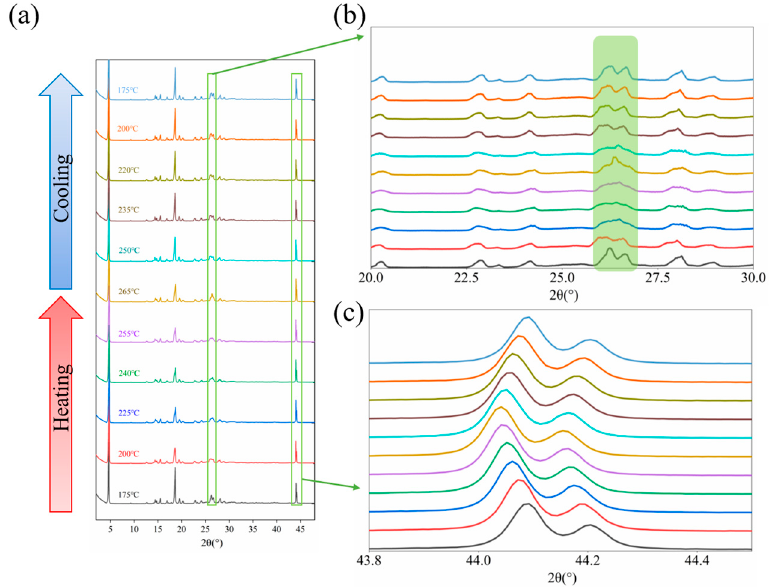
Figure 4. ( a ) VT-PXRD patterns of TMP-OA during heating/cooling from 175 ◦ C to 265 ◦ C. ( b ) Local magnification of X-ray diffraction peaks in the 2 θ range of 20 ◦ ~30 ◦ . ( c ) The PXRD peak shift of near 44.1 ◦